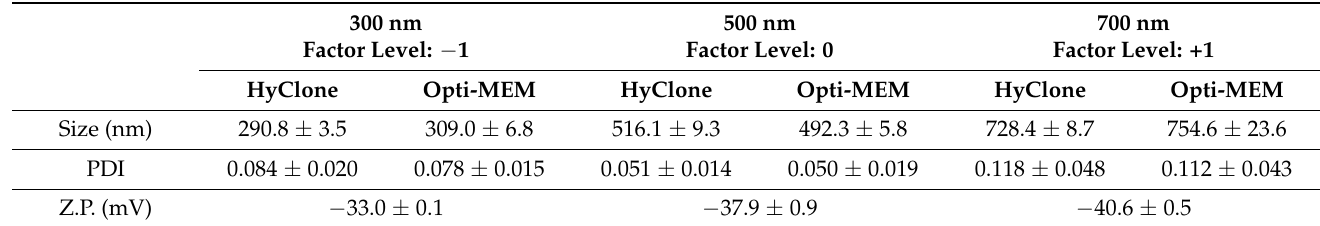
Table 1. Summary of the average ( ± standard deviation) hydrodynamic diameter (size), polydispersity index (PDI), and zeta potential (Z.P.) of the BSA coated PDNPs with sizes corresponding to factor levels − 1, 0 and 1 in both HyClone Pure water and Opti-MEM. Z.P. was only measured for BSA-coated PDNPs in HyClone Pure water. 300